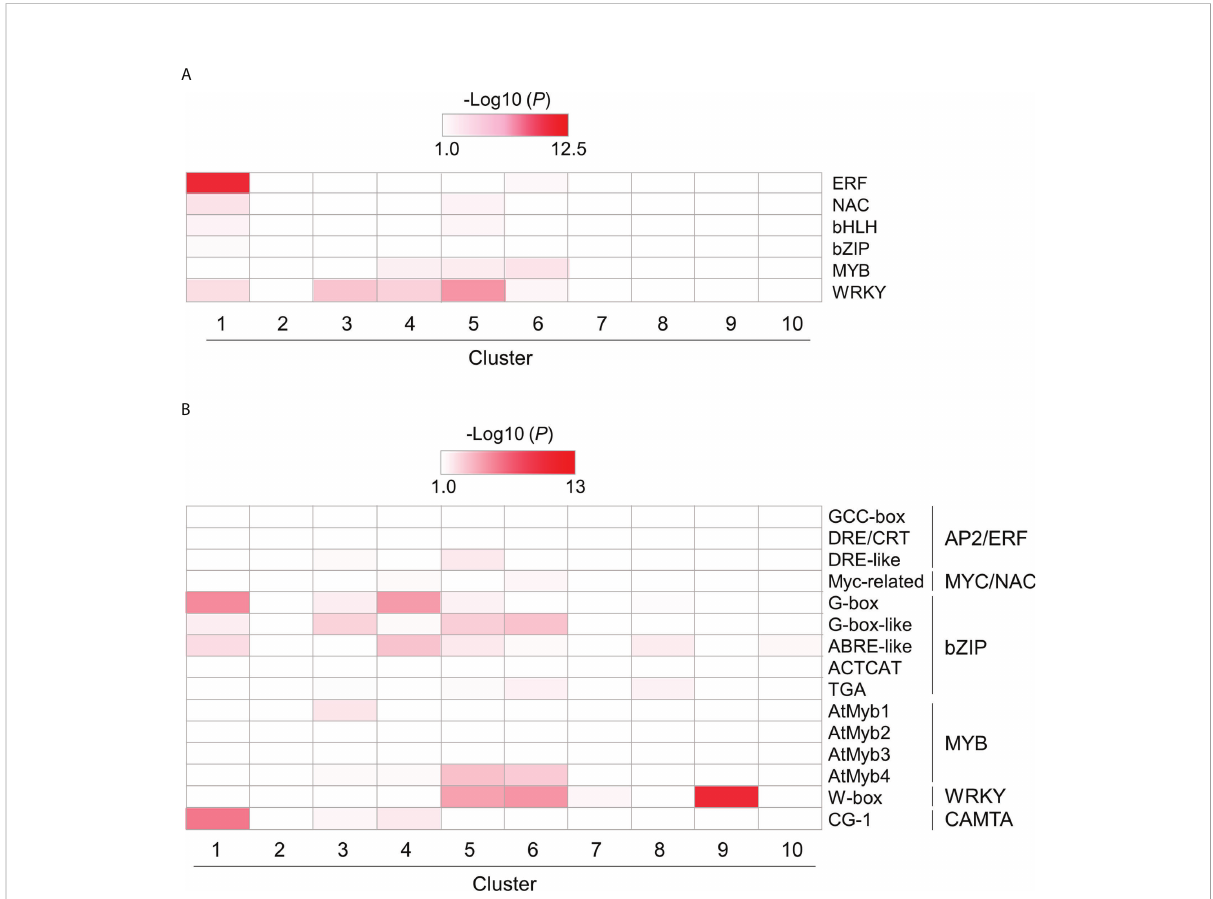
FIGURE 6 Over-representation analysis of selected DEGs encoding transcription factors (TFs) and harboring cis-regulatory elements in their promoter region. DEGs encoding TFs (A) and harboring cis-regulatory elements in their promoter region (B) were identi fi ed in fl g22-treated Brachypodium distachyon leaf disks. The p -values of the listed TF-encoding and cis-regulatory motif-containing DEGs, which the selected TF could target, were analyzed in each cluster. The p -values were converted to logarithmic values (-Log10) and displayed as a heatmap, with darker colors indicating